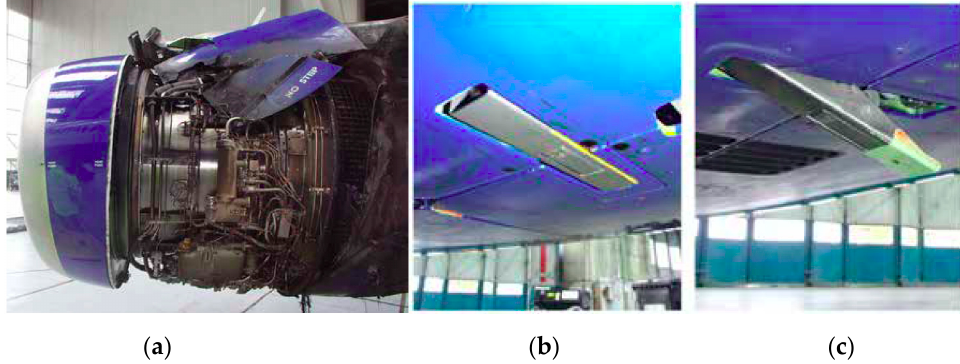
Figure 14. ( a ) Resultant damage to the right engine, with the cowling detached; The difference in the cowl fully locked ( b ) and just latch but not locked ( c ) [35].